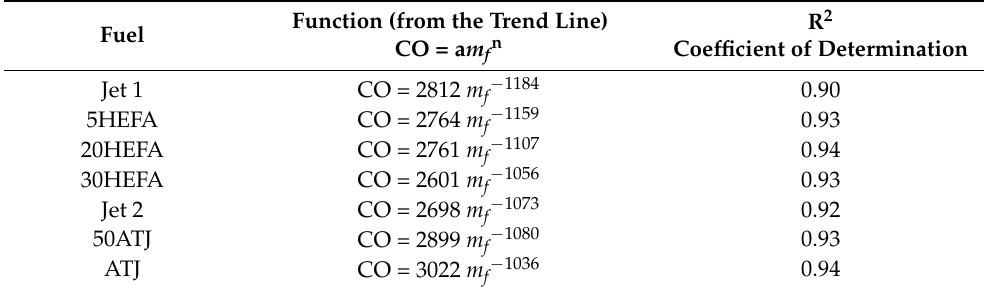
Table 2. The power functions describing relationships between CO concentration in exhaust gases and fuel mass flow